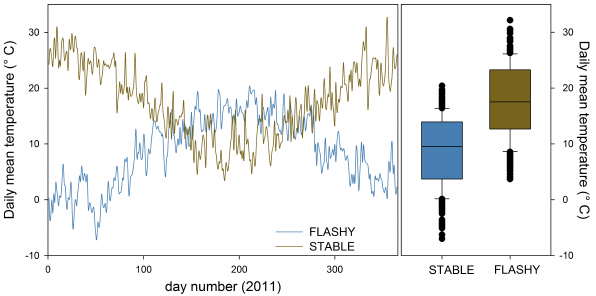
Figure 1. Left panel: mean daily air temperature variation for a tem- perate/STABLE (Danish) and a subtropical/FLASHY (Uruguayan) catchment in 2011. Right panel: boxplots of the same data. The boundary of the box closest to zero indicates the 25th percentile, a line within the box marks the median, and the boundary of the box farthest from zero indicates the 75th percentile. Whiskers above and below the box indicate the 90th and 10th percentiles. Black dots display